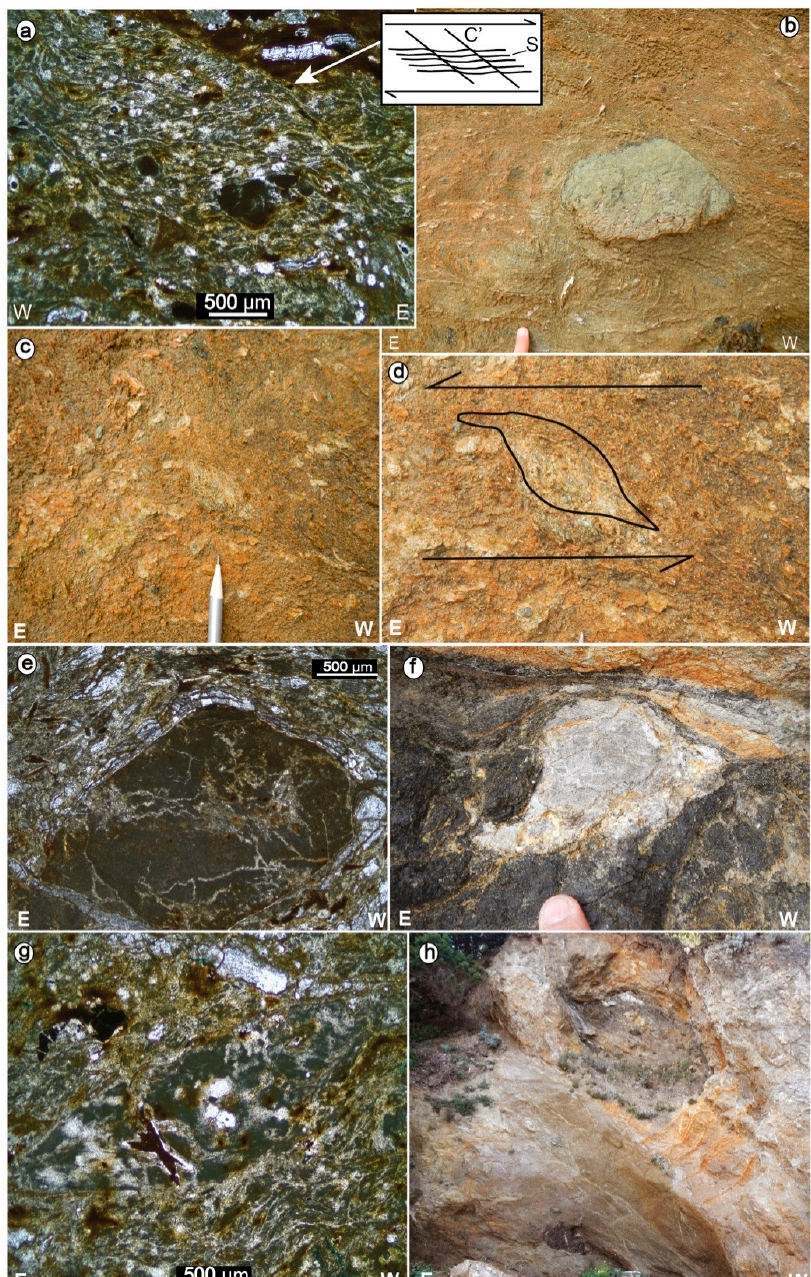
Figure 6. Mylonitic domain within quartzofeldspathic rocks. ( a ) crossed polars micrograph of a highly foliated matrix with small porhyroclasts and shear bands; ( b ) isolated carbonatic porphyroclast; ( c , d ) sigmoidal carbonate porhyroclasts and its detail with the line drawing, pointing to a top-to-the east shear sense; ( e ) crossed polars micrographs displaying an altered lithic porphyroclast, a ff ected by small carbonate veins and wrapped by magnesite ribbons; magnesite is also dispersed in the highly foliated matrix; ( f ) carbonate porphyroclast in a darker crystallized matrix; ( g ) crossed polars micrographs showing lithic porhyroclast dispersed in an intensely foliated and crystallized matrix. ( h ) large δ -type ultramafic porphyroclast pointing to a top-to-the east shear sense.